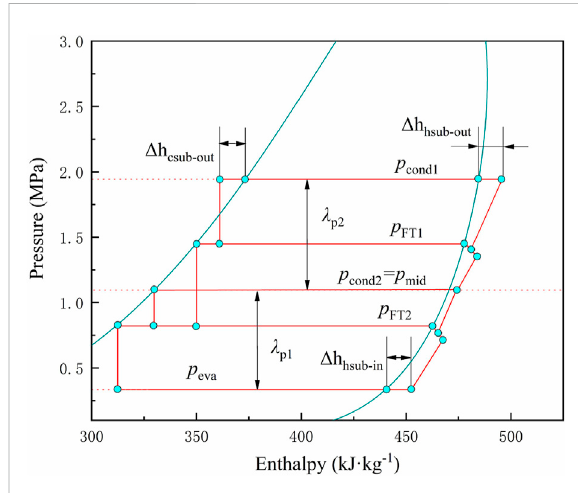
FIGURE 3 The pressure and enthalpy characteristics of the dual- fl ash compound circulation